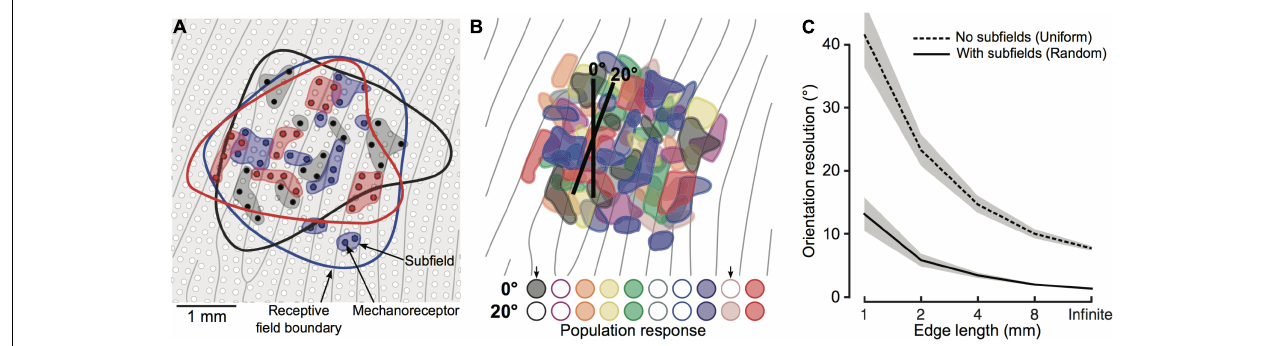
FIGURE 8 | (A) Schematic of skin patch with papillary ridges (grey lines) and mechanoreceptors (white and colored dots). Blue, black and red dots represent receptors innervated by one of three first-order tactile neurons. Colored contour represents first-order neurons receptive field, while shaded area behind the colored dot represents subfields. (B) Color-coded subfields for 10 first-order tactile neurons. Representation of 10 first-order tactile neurons with overlapping receptive field and subfields (color-coded). First-order neurons are activated if the edge falls on one subfield. Here, the activation response is shown for 10 neurons and 2 edges of 2 mm with different orientation (0 ◦ and 20 ◦ ). Colored circles are filled if the neurons is active and empty otherwise. (C) Output of the two tested models (subfields vs. uniform sensitivity). The lines indicate the mean and the shaded areas represent the 95% confidence interval. Image from Pruszynski et al. (2018) reproduced under the terms of a Creative Commons Attribution